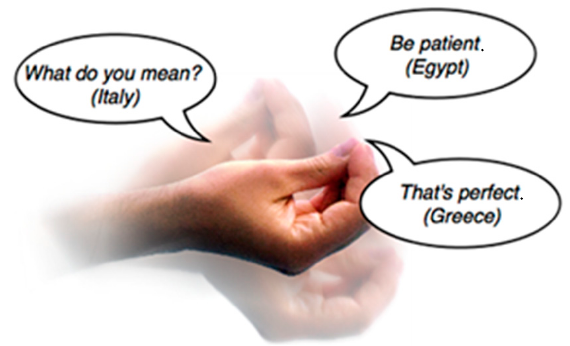
Figure 1. A culturally dependent illustrator gesture.